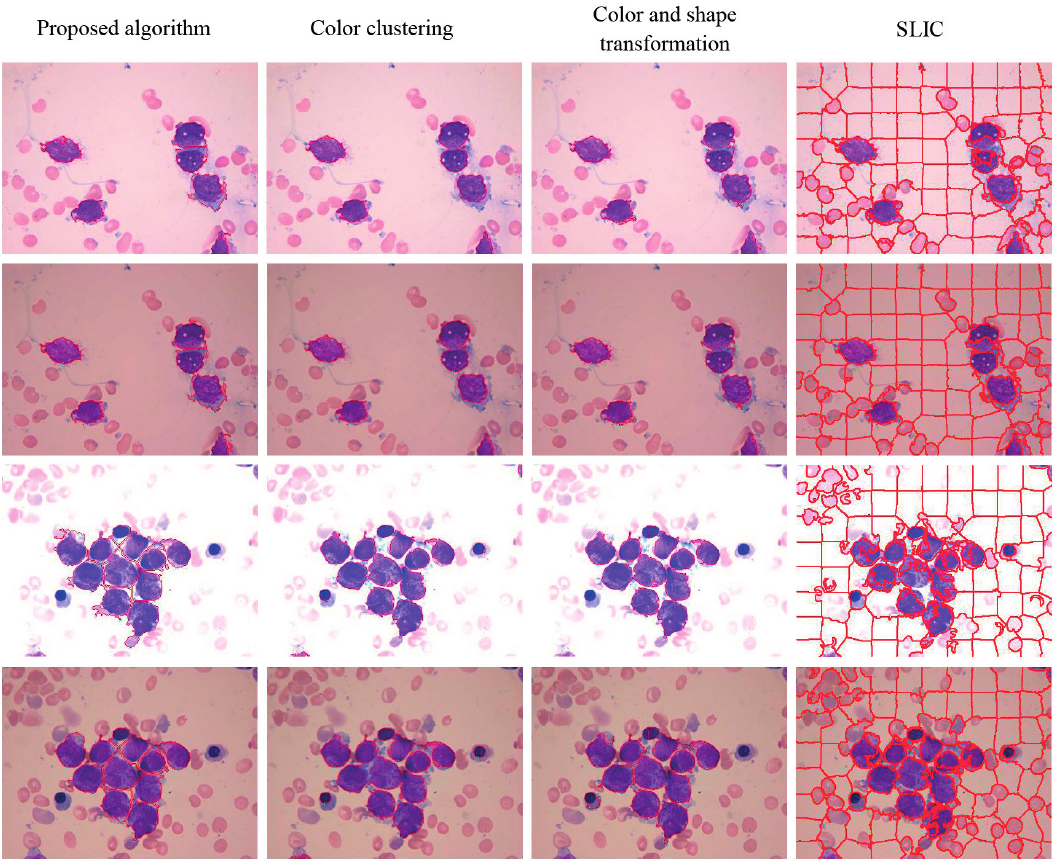
Figure 16. Segmentation results of AML images (segmented WBCs marked with red curves).